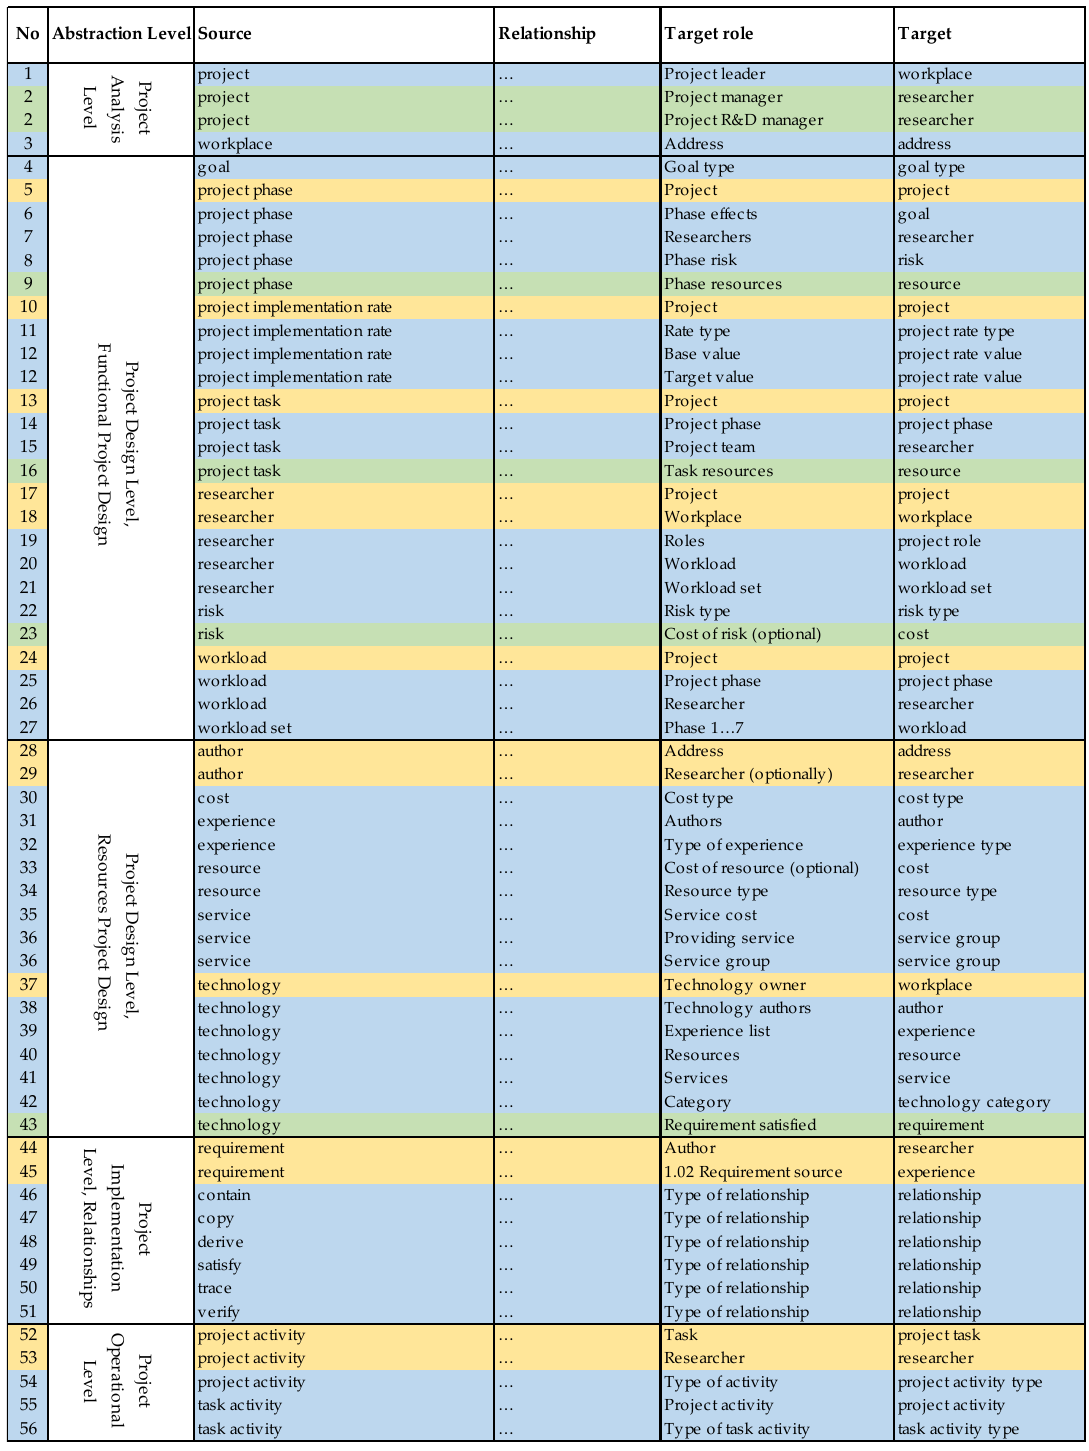
Figure 17. ResearchML abstraction layers, objects, relationships, target roles.